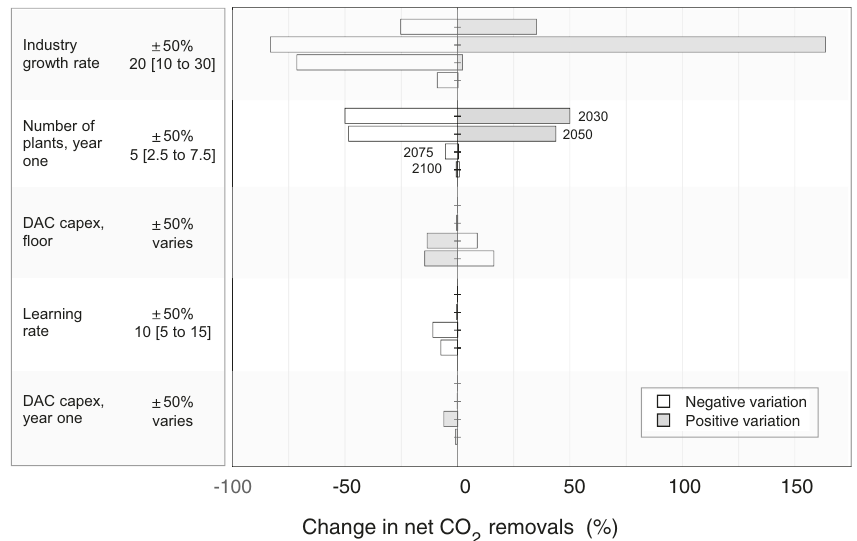
Fig. 7 Net CO 2 removal sensitivity to upscaling parameters, DAC costs, and learning rate. Bars show the mean change across scenarios in net CO 2 removal in 2030, 2050, 2075, and 2100 due to variation in the single parameter. Parameters (nominal value and plus/minus variation) are listed at left. White bars show the effect of negative variation (e.g., decreasing growth rate or cost) and gray bars show positive variation. Funding is from the club of democracies. (For results on all key parameters see Supplementary Figs. 16 and